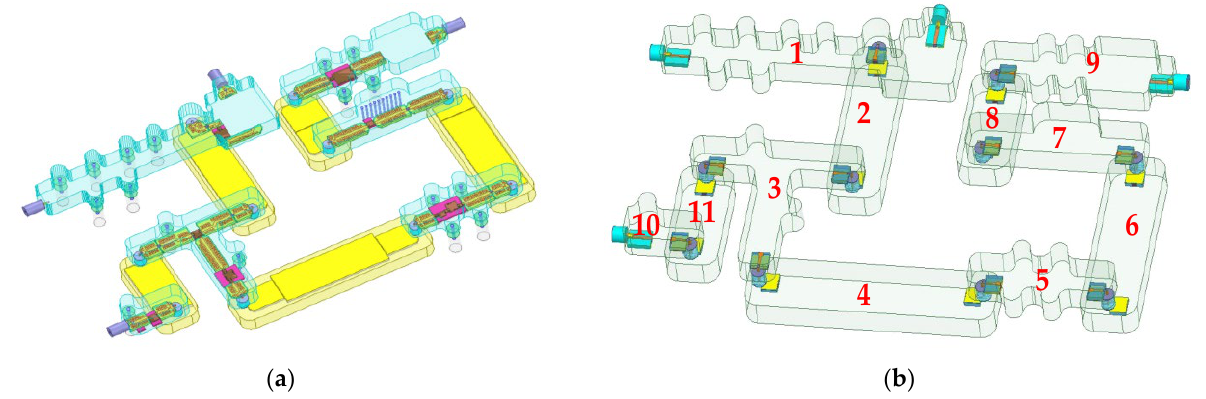
Figure 23. Packaging model of the Ka band receiving SIP. ( a ) Structure of the Ka band receiving SIP; ( b ) Number of all the cavities. Table 6. The lowest resonant frequency of each cavity of the SIP. Cavity Number The Lowest Resonant Frequency of Cavity